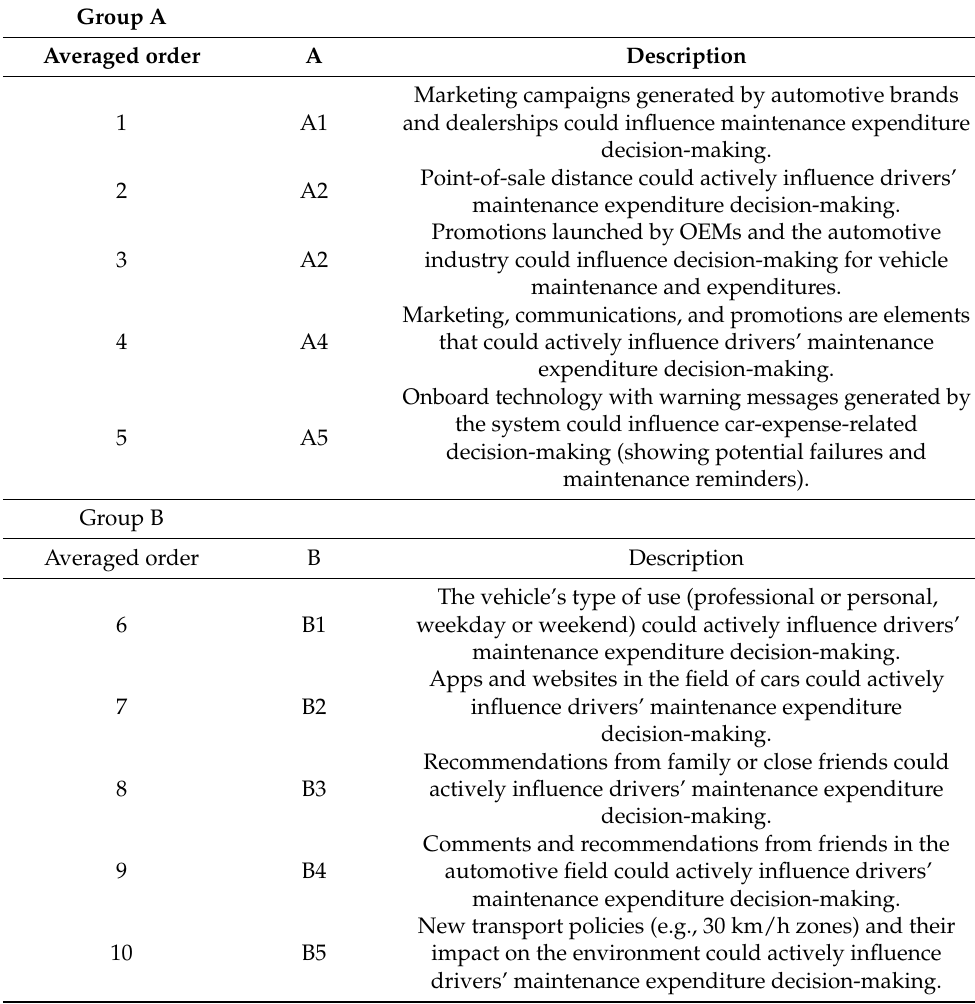
Table 3. Group A and B creation and associated ranking from the first round of Delphi